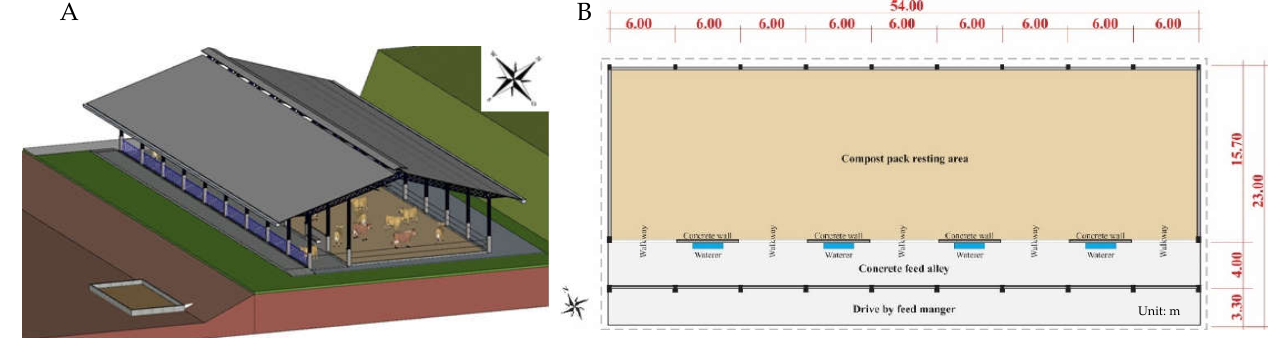
Figure 1. 3D ( A ) and 2D ( B ) schematic drawing of the barn .